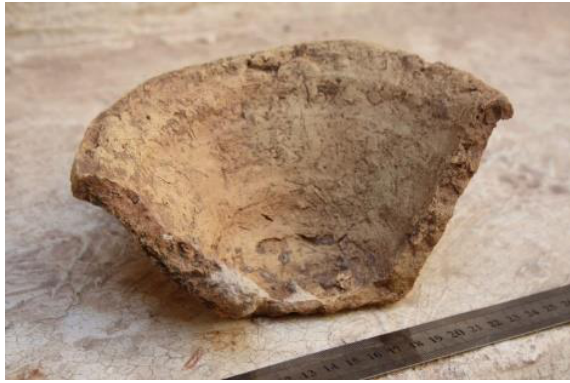
Figure 6. A bevelled-rim bowl from Qala Shila